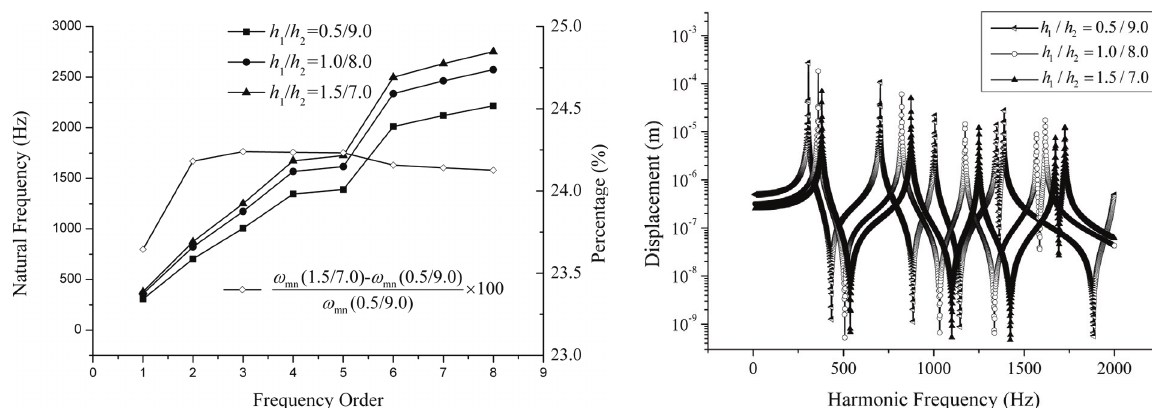
Fig. 15. Natural frequencies and their relative difference. Fig. 16.